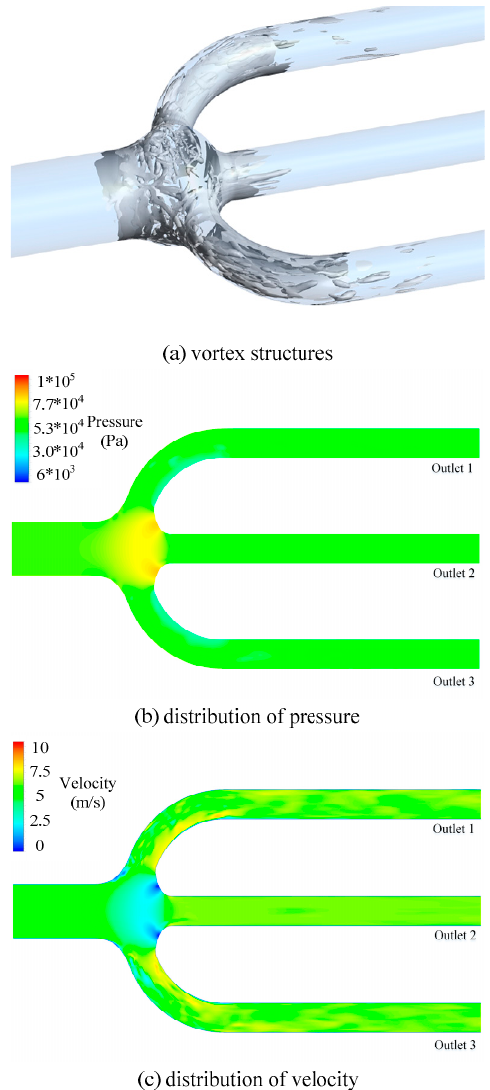
Figure 12. Variations in the total pressure differences (case 1).